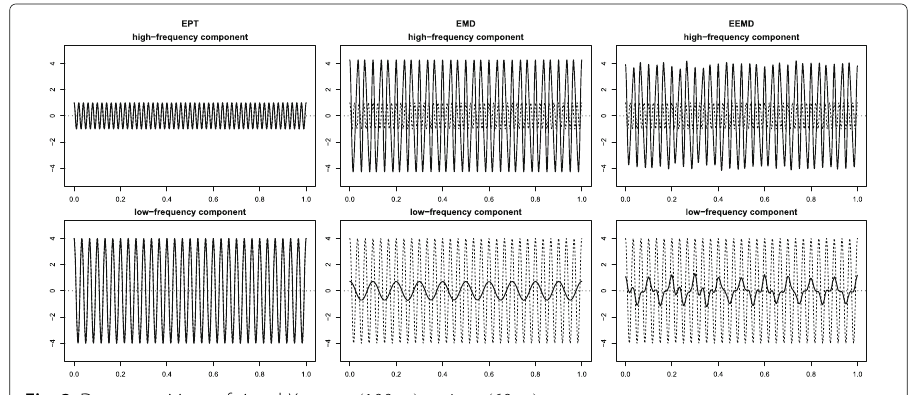
Fig. 2 Decompositions of signal X t = cos ( 100 π t ) + 4cos ( 60 π t